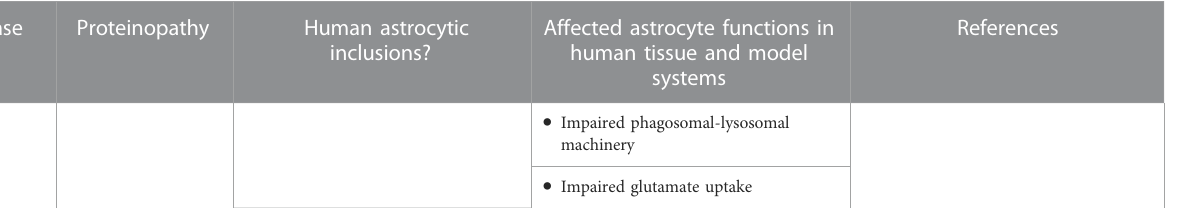
TABLE 1 ( Continued ) Neurodegenerative disease pathologies affecting